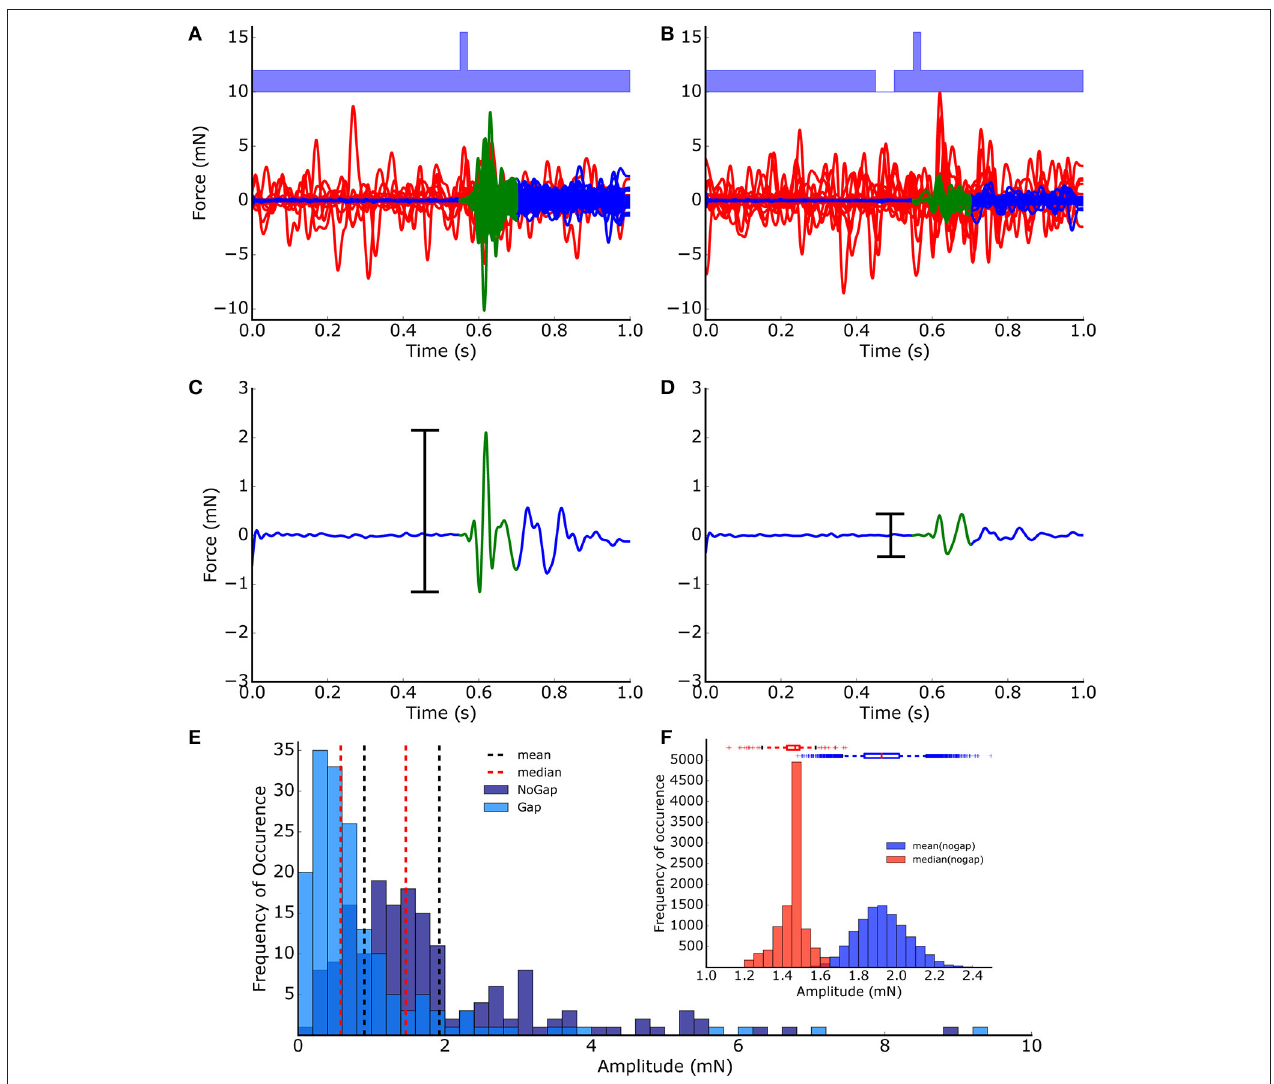
FIGURE 1 | ASR peak-to-peak amplitude extraction and distribution. Startle reflexes ( N = 200) of one animal from no-gap (A) and gap (B) condition measurements (light blue, band-noise, 2kHz). Valid trials (blue/green lines) and invalid trials (red lines) were classified automatically based on a low-pass filtering and threshold procedure. (C,D) The peak-to-peak-amplitudes (black bars) of the 150ms time intervals directly after the stimulus (green) was used as a measure of the strength of the startle reflex (startle reflex amplitude). (E) Frequency distribution of startle reflex amplitudes. (F) Distribution of means (blue) and medians (red) calculated from 10,000 bootstrapped data sets (no-gap ASR amplitudes, boxes: quartiles, whisker: 5–95% quantiles); The bootstrap procedure provides evidence that the median is the more robust measure for the startle amplitudes compared to the mean.